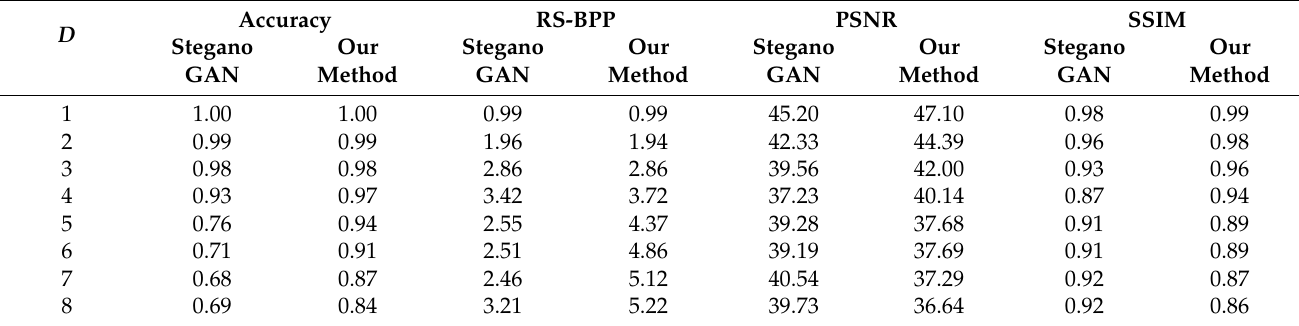
Table 1. A comparison of our method and SteganoGAN with different capacities.